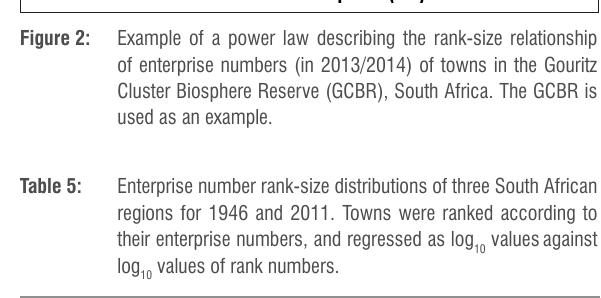
Table 4: Population rank-size distribution analyses spanning the period 1911 to 2004 of the 12 Eastern Cape Karoo towns. Towns were ranked according to population sizes of their urban and rural areas, which were regressed as log values of rank numbers.